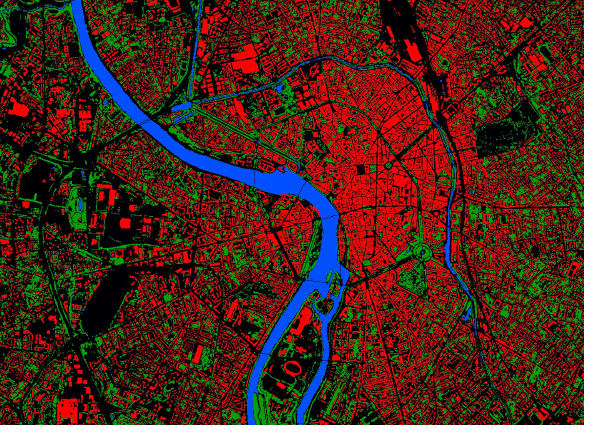
Figure 2. Toulouse dataset: a color view of the Pleiades image and its corresponding ground truth. Color code: buildings , water , tree , background